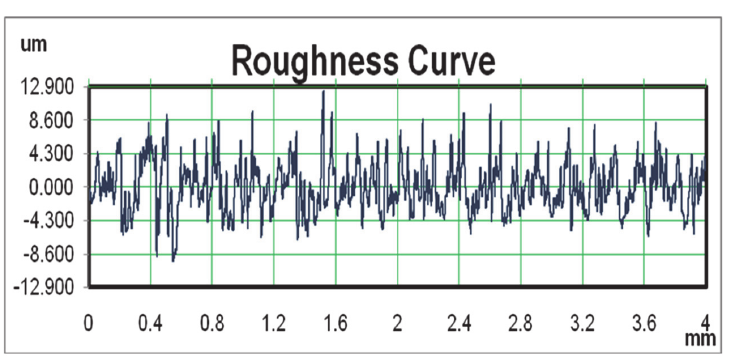
Fig. 6. Roughness curve for confirmation experiment (A 4 B 1 C 1 D 5 E 4 F 2 )